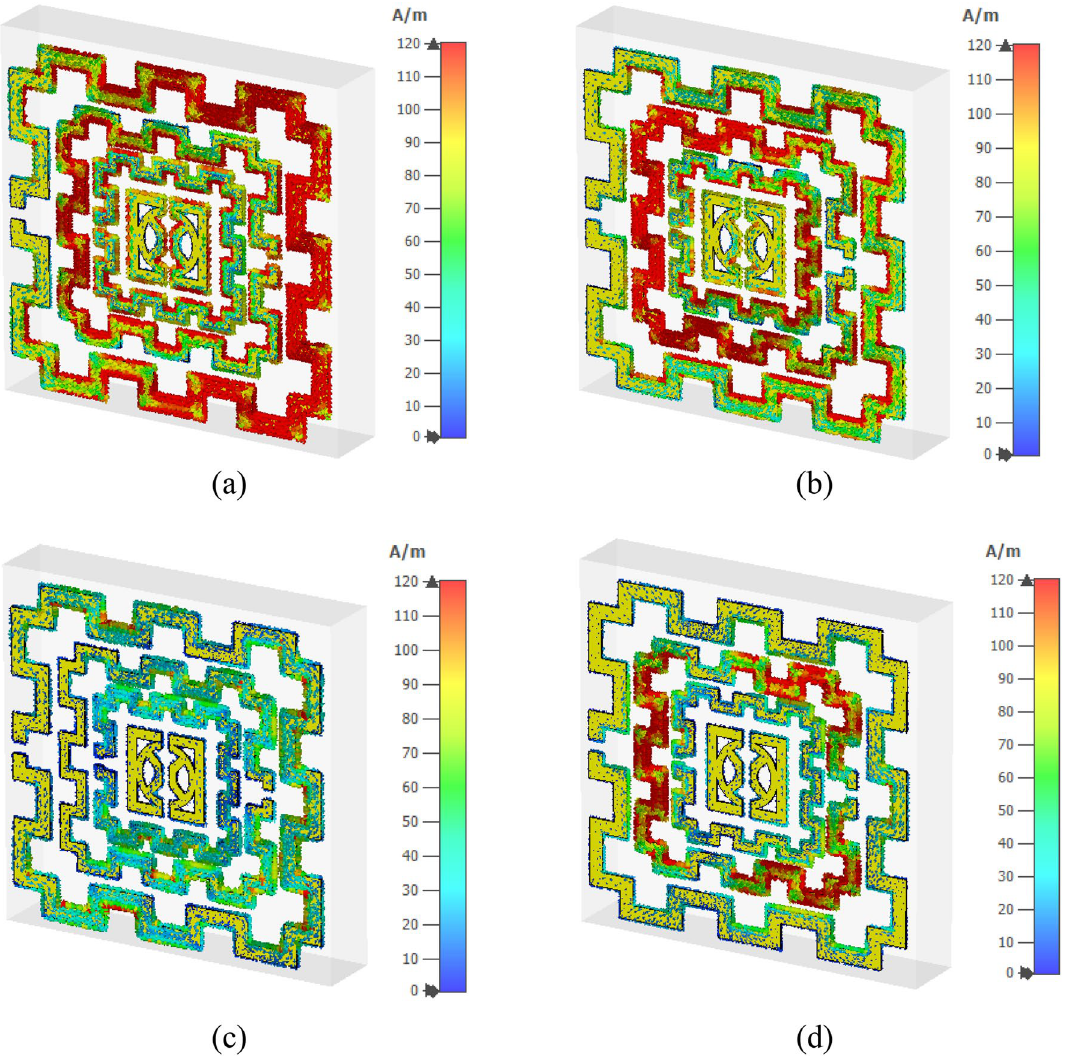
Figure 11. Surface current distribution ( a ) 2.48 GHz ( b ) 4.28 GHz ( c ) 9.36 GHz ( d ) 13.70 GHz. (CST STUDIO SUITE 2019, https:// www. 3ds. com/ produ cts- servi ces/ simul ia/ produ cts/ cst- studio- suite) 28